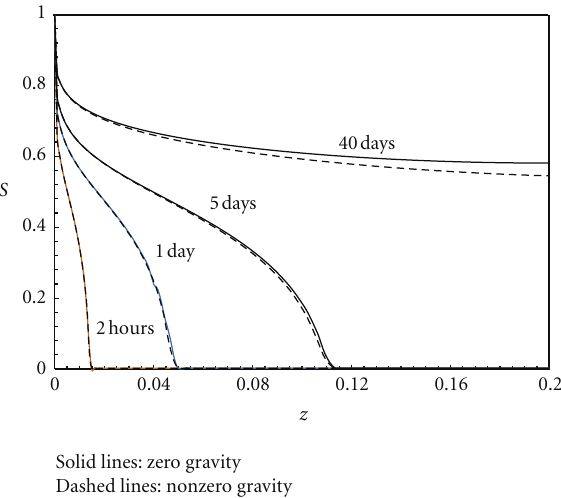
Solid lines: zero gravity Dashed lines: nonzero gravity Figure 9: Comparison between considering and neglecting gravity e ff ect on water saturation against z -axis of Case C, at x = 0 . 15 m.